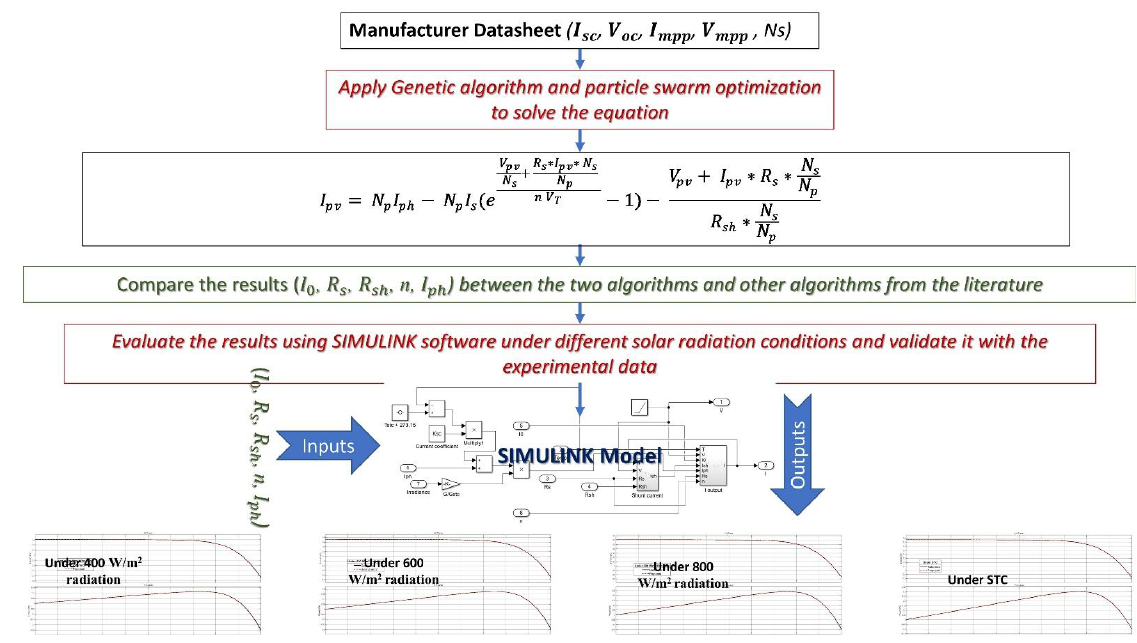
Figure 1. Methodology of the proposed